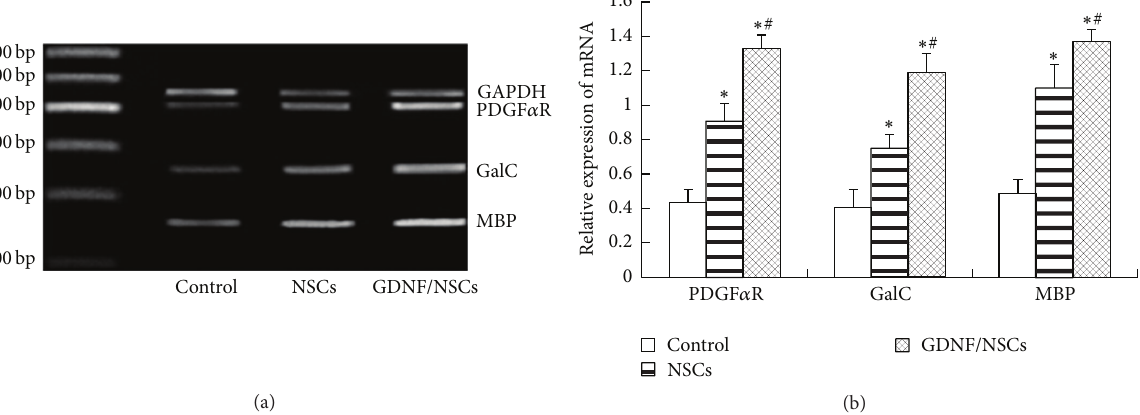
Figure 5: GDNF increased expression of mRNA for oligodendrocyte lineage cells. (a) mRNA expression of PDGF 𝛼 R, GalC, and MBP in the cerebrallesionareasineachgroup.(b)RelativeexpressionofPDGF 𝛼 R,GalC,andMBPmRNAfollowingtransplantation(PDGF 𝛼 R/GAPDH, GalC/GAPDH, and MBP/GAPDH) (mean ± SD, 𝑛 = 5 ). ∗ Compared with control group, 𝑃 < 0.05 ; # compared with NSCs group, 𝑃 < 0.05